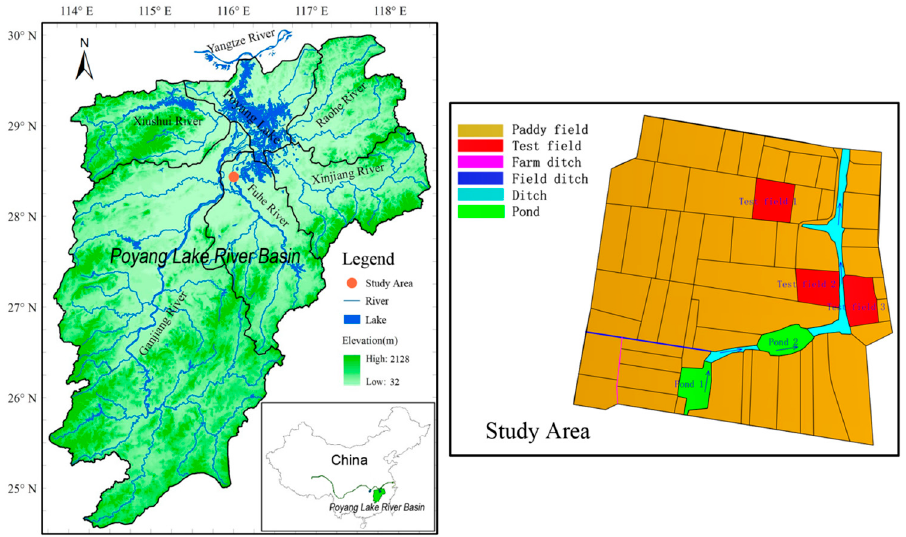
Figure 1. Generalized map of the study area.